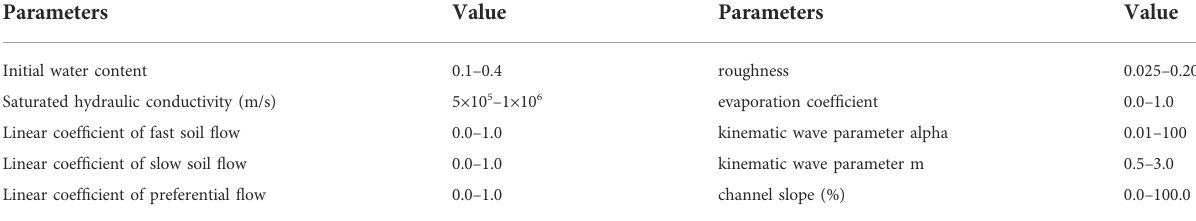
TABLE 6 The main parameters of hydrological